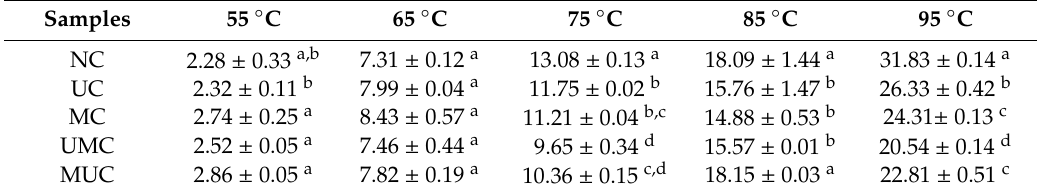
Table 2. Swelling power (g / g) of native and modified chestnut starches. Samples